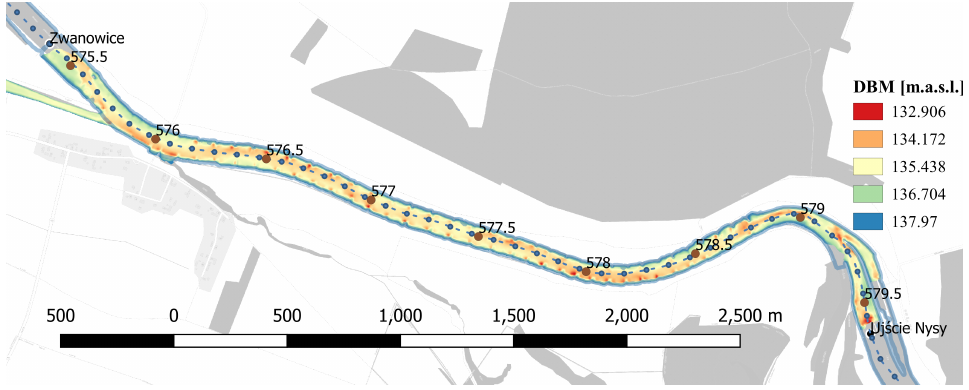
Figure 6. DBM of the reach from the barrage “Uj´scie Nysy” to the Barrage “Zwanowice”. For this contribution, six interpolation methods were used for the comparison of the RBM/DiBM generation along the Odra Cascade, namely: RBF, IDW, TIN, NN, OK, and Spline. In Figure 7, the generation of six different bathymetric models is depicted for a short nonstraight reach, while in Figure 8, the DiBMs are depicted for a straight reach. onsite geodetic surveyed data are compared.